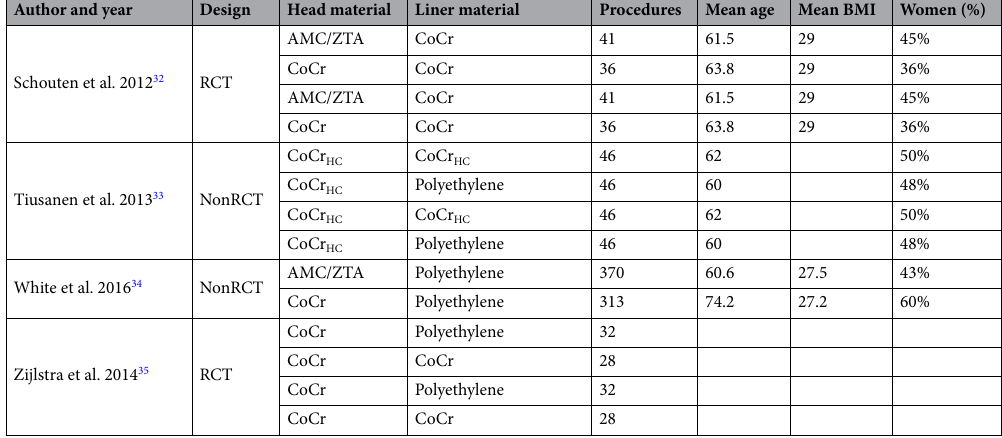
Table 1. Generalities and patient baseline of the included studies. RCT randomised controlled trial, Al 2 O 3